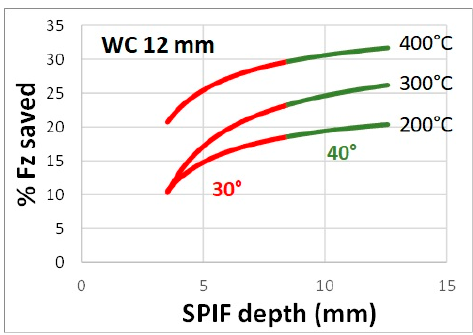
Figure 15. Reduction of vertical force for each temperature with respect to room temperature.